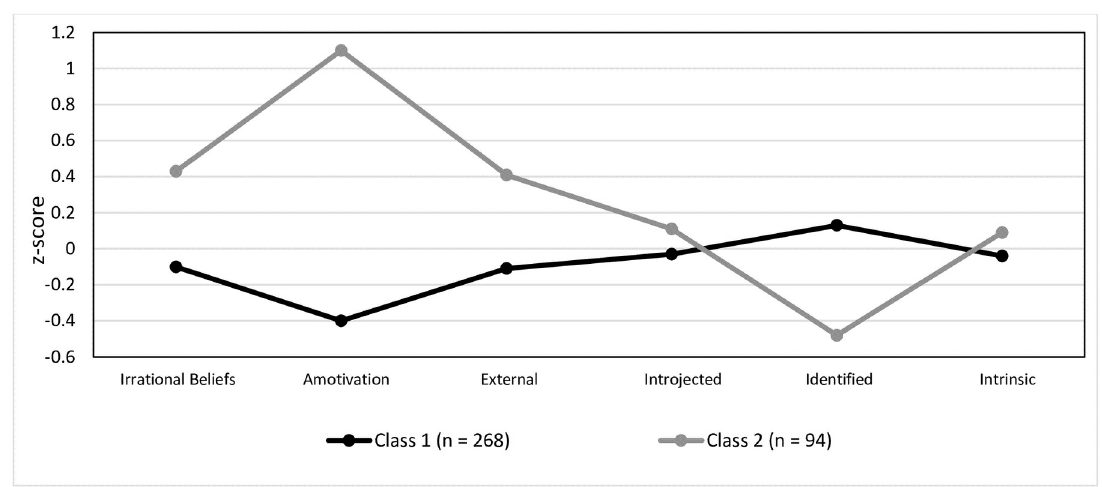
Fig 2. Latent profile analysis. Estimates of the variables for the two latent profile analysis (LPA) classes in Study 2.